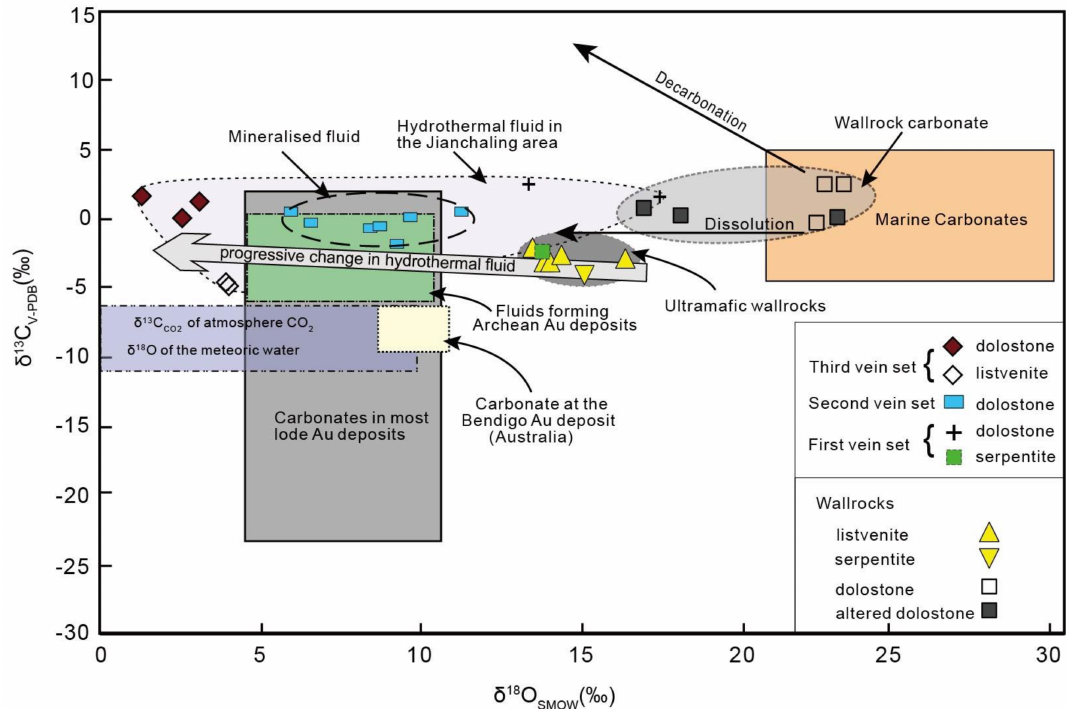
Figure 7. δ 18 O SMOW versus δ 13 C V-PDB plot for the Jianchaling Au deposit [21]. Data sources: greenschist facies carbonate rocks after [74]; reduced C in sedimentary and metamorphic rocks after [75]; carbonates in most orogenic Au deposits after